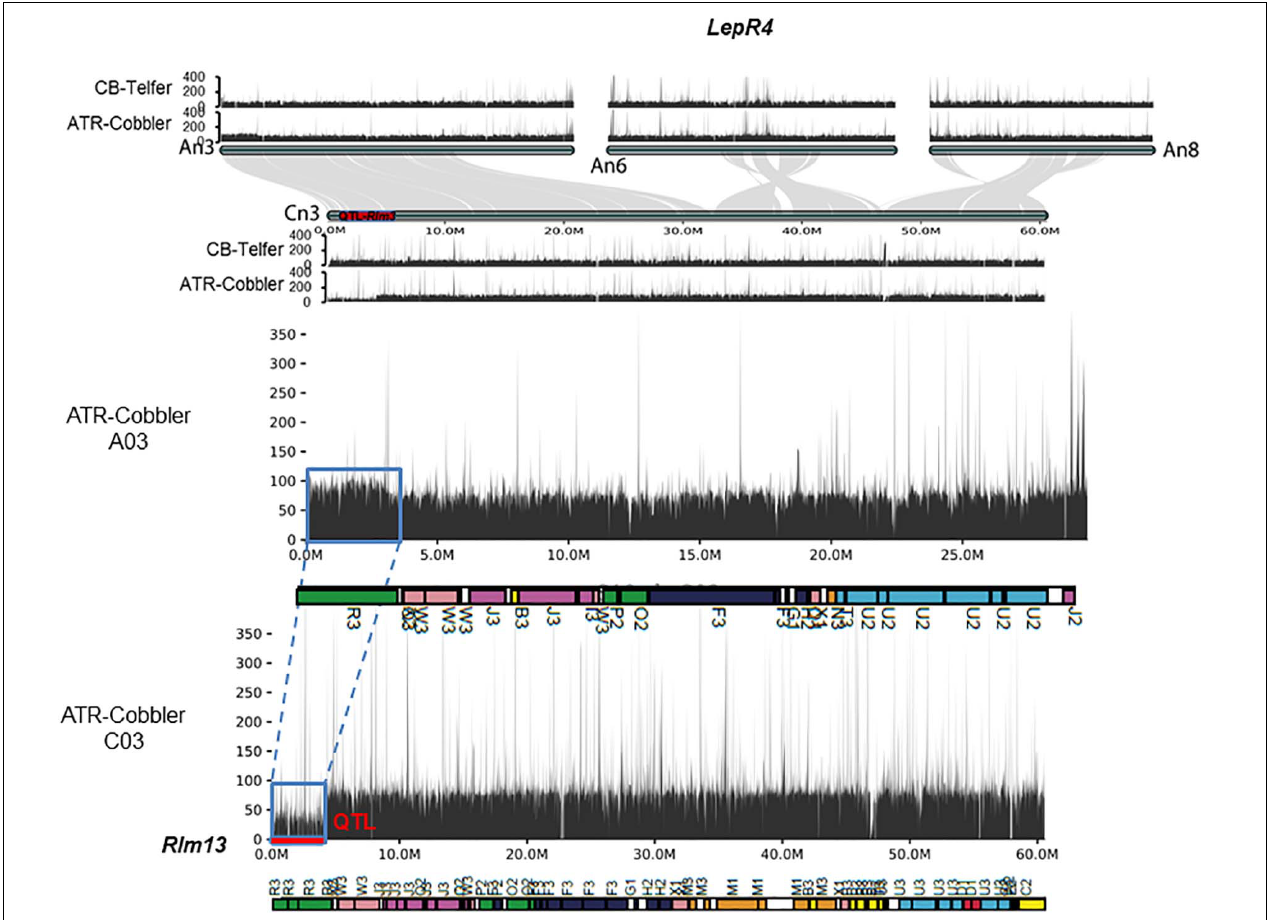
FIGURE 5 | Syntenic relationships between LepR4 (on A06) and homoeologous group 3 chromosomes, encompassing the Rlm13 region on chromosome C03. The gene syntenies between A03, A06, A08, and C08 are shown with gray connections. The Rlm13 region is marked in red. The coverage depth of homoeologous chromosomes was calculated after mapping resequenced reads to the Darmor- bzh genome assembly version 4.1. In ATR-Cobbler, the coverage depth of the Rlm13 region on chromosome C03 is less than 50 (1 × ), while in A03, the coverage depth is double ( ∼ 100), indicating the occurrence of HE between A03 and C03. The syntenic region, subjected to HE, is marked with dotted/solid lines (in blue). Gene sequences which were located in different ancestral blocks are also marked in different colors. Localization of marker sequences to ancestral blocks was carried out using the method described previously (Zou et al.,